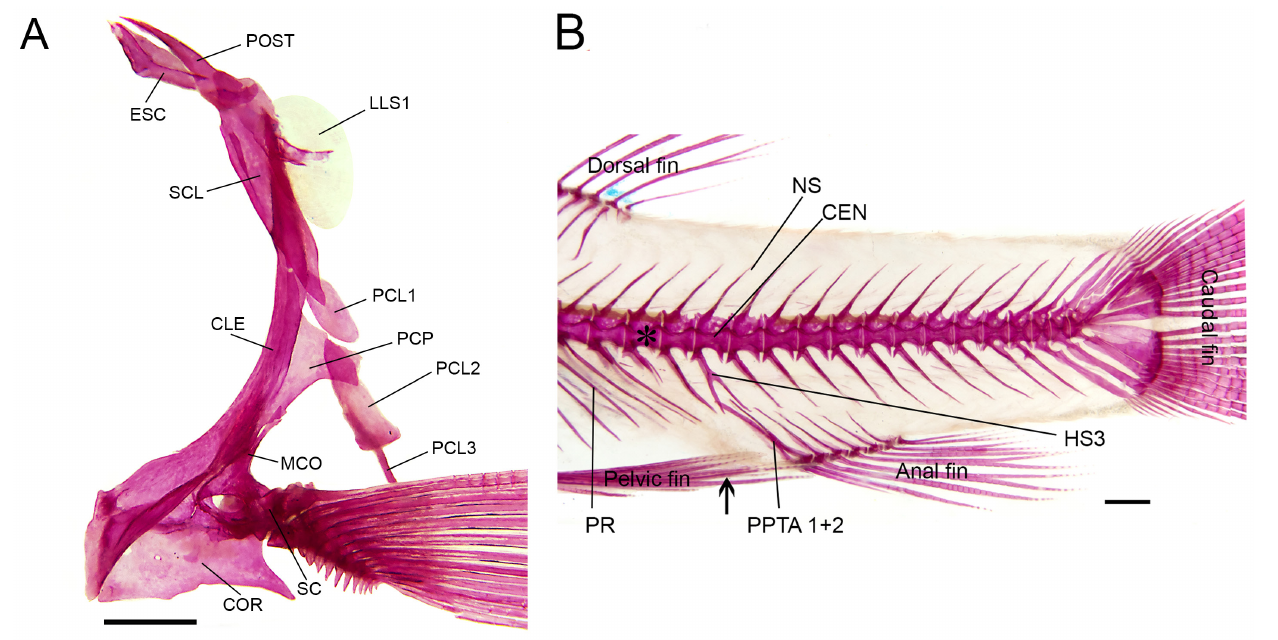
FIGURE 4 | Osteological characteristics of fins in Characidium kalunga , MZUSP 114054, paratype. A . Left pectoral girdle in lateral view; B . Caudal peduncle in lateral view – left intermuscular bones removed. Abbreviations: arrow, position of anus; asterisk, first caudal vertebra; CEN, centrum; CLE, cleithrum; COR, coracoid; ESC, extrascapular; LLS1, first lateral-line scale; HS3, third haemal spine; MCO, mesocoracoid; NS, neural spine; PCP, posterior cleithral process; PR, pleural rib; PRAF 1+2, fused anal-fin proximal radials 1 and 2; PTC1, postcleithrum 1; PTC2, postcleithrum 2; PTC3, postcleithrum 3; POST, posttemporal; SC, scapula; SCL, supracleithrum. Scale bar = 1 mm.